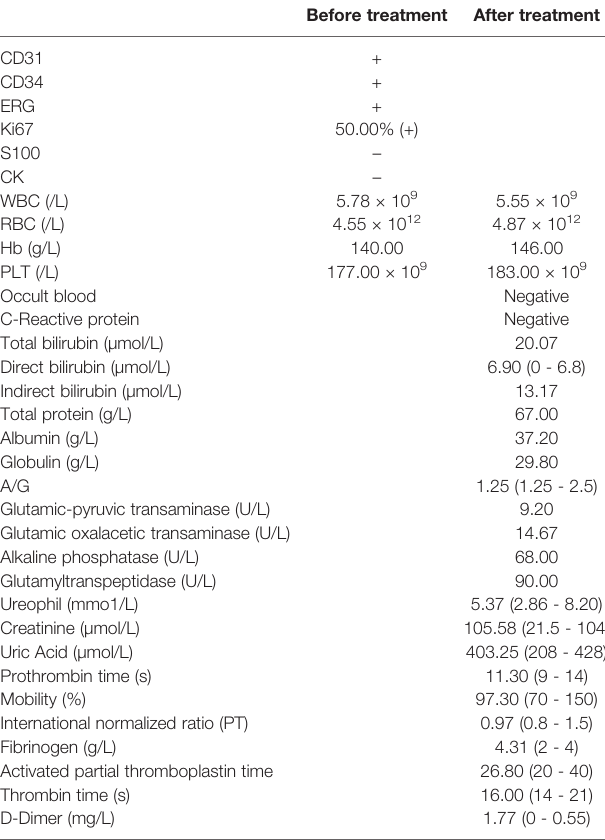
TABLE 1 | Results of laboratory measurements. Before treatment After